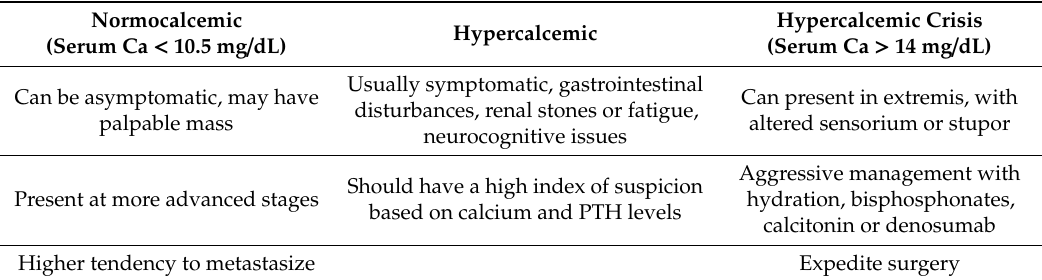
Table 1. Variable presentation in parathyroid cancer. Parathyroid hormone,